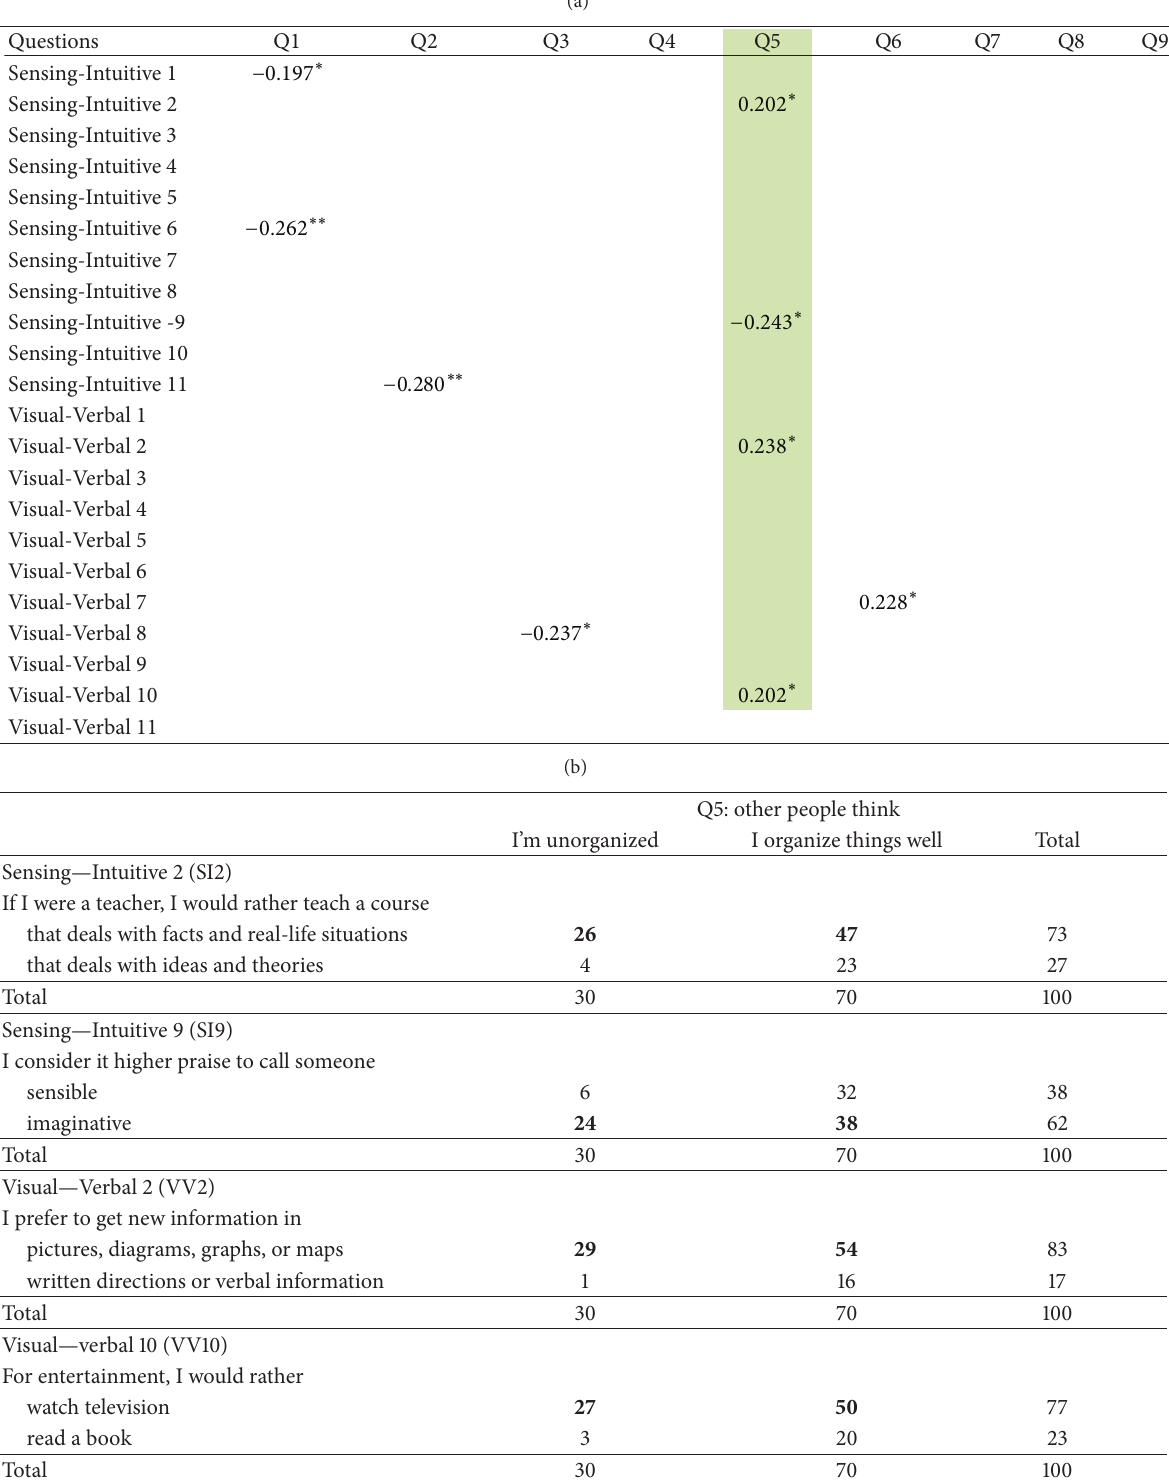
Table 9: (a) Correlation between learning styles (perception and input dimensions) and cognitive alert styles. (b) Correlation between learning styles (SI2; SI9; VV2; VV10) and cognitive alert styles (Q5).